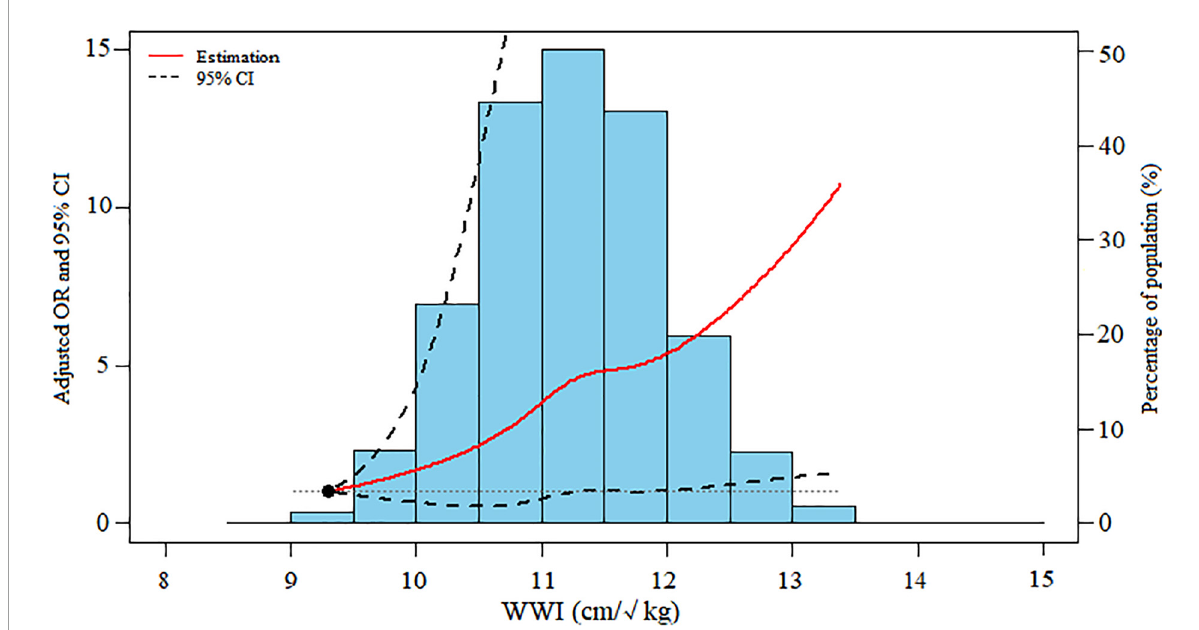
FIGURE2 Dose-response association between WWI levels and severe AAC. Data were ORs (solid line) and 95% CIs (dashed lines) from multiple logistic regression analysis with restricted cubic splines, with WWI 9.30 cm/ aortic calcification; OR, odds ratio; CI, confidence